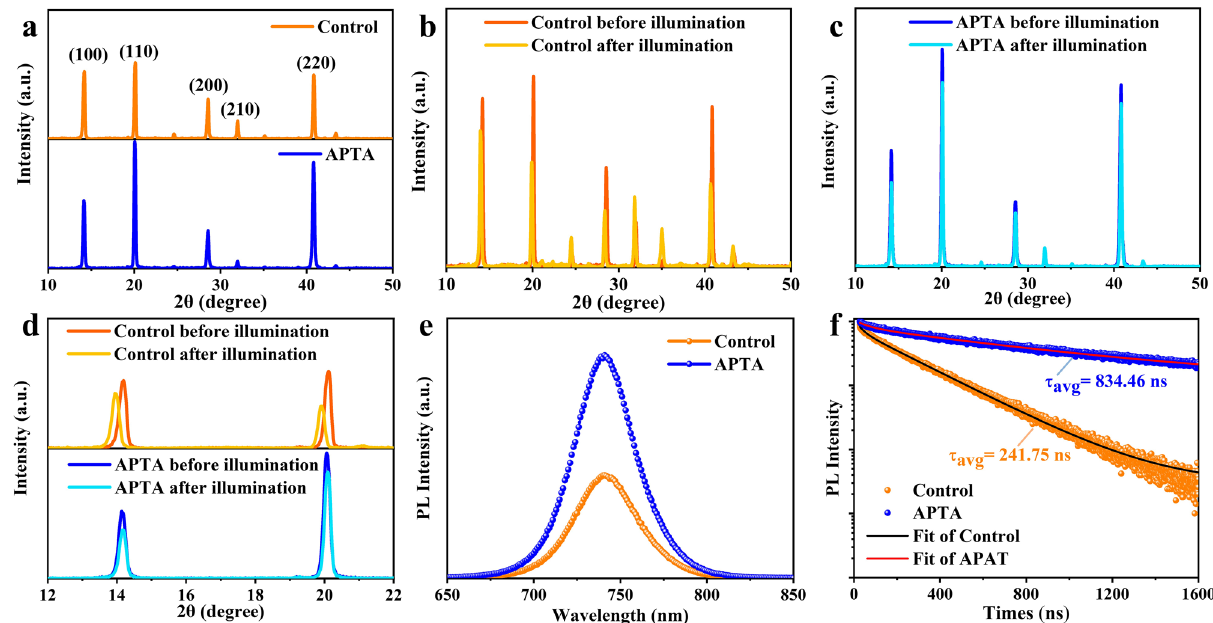
Fig. 2 a XRD patterns of the WBG perovskite films without and with APTA. The evolution of XRD patterns of the WBG perovskite films b without and c with APTA upon continuous light illumination. d Enlarged XRD patterns of the WBG perovskites w/o and with APTA before and after continuous light illumination. e Steady-state photoluminescence spectra (PL) of WBG perovskites with and without APTA and the corre- sponding f time-resolved PL